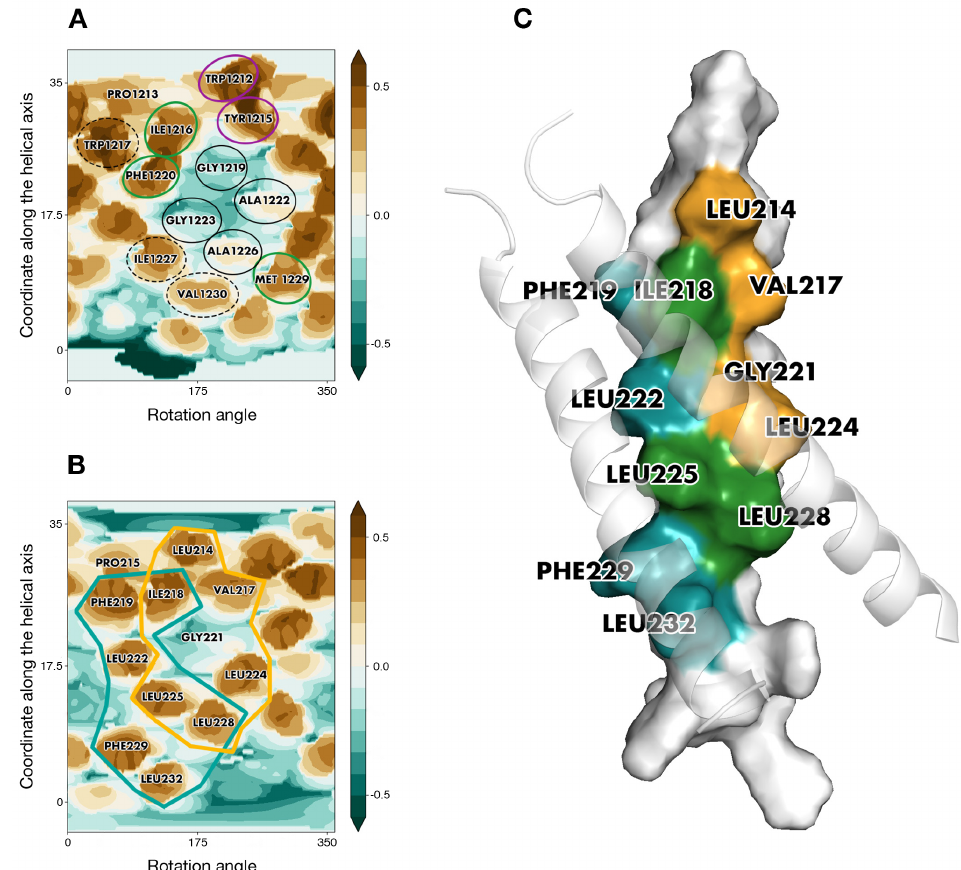
Figure 3. The similarity between S-TMD and a candidate template. ( A ) Interface B is one of the dimerization solutions predicted for S-TMD. ( B ) Overlapping helix–helix interfaces for one of the chains in TNFR-1. TNFR-1’s interface 1 and interface 2 are enclosed in golden and teal lines, respec- tively. Identical positions are encircled in purple, conservative and semi-conservative residues are encircled in green, non-conservative residues present on the helix–helix interface are encircled in black, and residues in S-TMD that could be part of the helix–helix interface if the latter were similar to that of TNFR-1 are enclosed in dashed lines. For other details, see the legend in Figure 2B. ( C ) A 3D model of the TMD of TNFR-1. Residues that are part of interface 1, part of interface 2, and part of both interfaces are colored golden, teal, and green, respectively. One of the helices is rendered in surface representation, while the other two helices are shown in cartoon representation and are